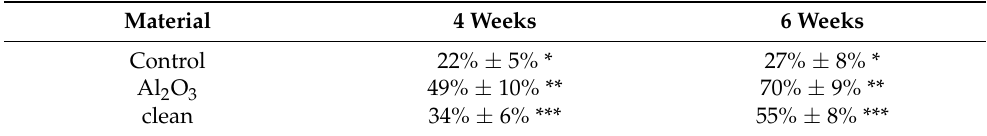
Table 5. Bone index contact (BIC) for different types of Ti dental implant surfaces and after 4 and 6 weeks of implantation. Statistical differences for each column are indicated by single asterisk and double or triple asterisk symbols ( p < 0.05).